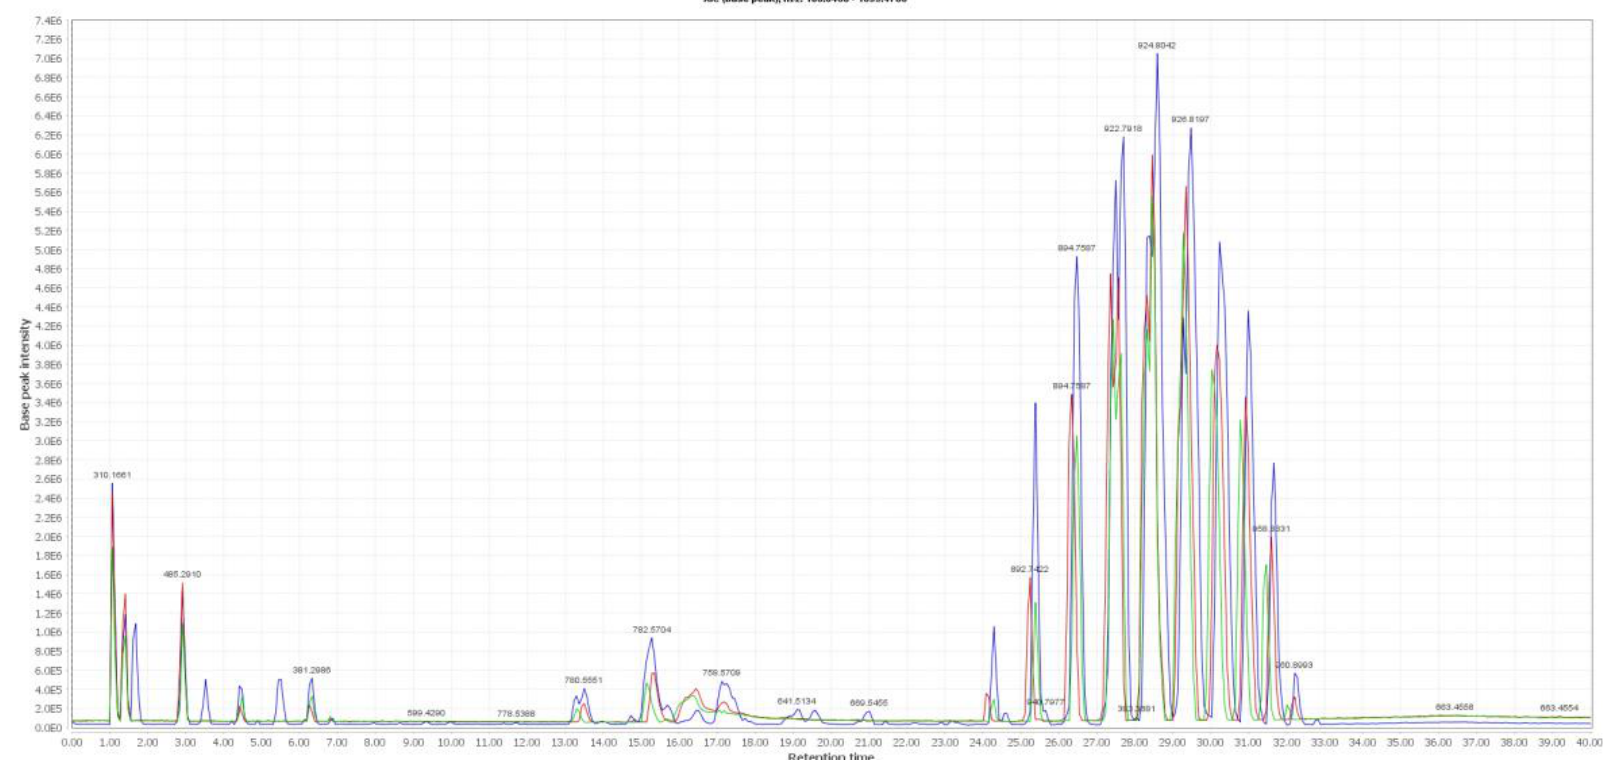
Figure 3. Example of total ion current map of lipids from control and mutant lines of Arabidopsis mature seeds in positive-ion mode.